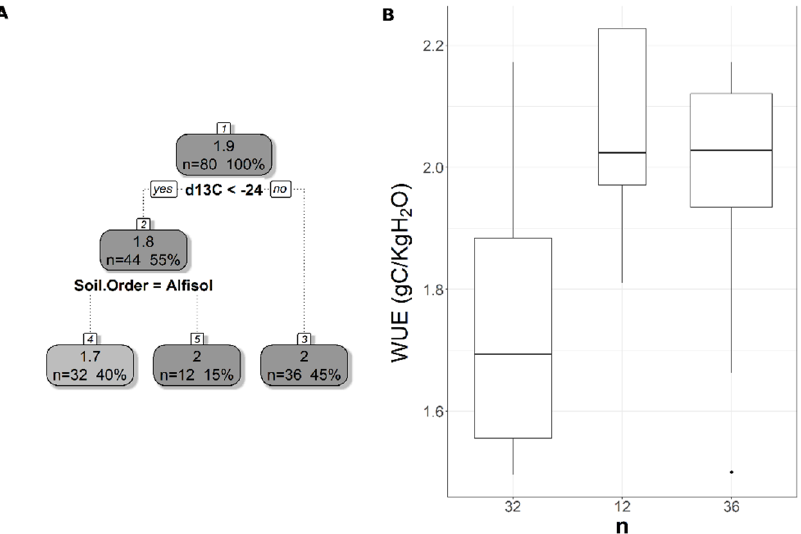
Figure 4. Pruned regression tree for ( A ) MODIS-based WUE predicted as a function of two significant variables. The number in boxes 1 and 2 represent the mean CUE SIF of the node, n values represent the terminal node size, soil variables names under the boxes represent the splitting criterion, and the numbers in boxes 3–5 represent the mean estimated CUE. Note that the position of “yes” and “no” at each split represents the decision split at each node. ( B ) Boxplots showing the distribution of WUE in each terminal node in the regression tree. The model has r 2 of 0.39 and a MAE of 0.175 gC/KgH 2 O for WUE.